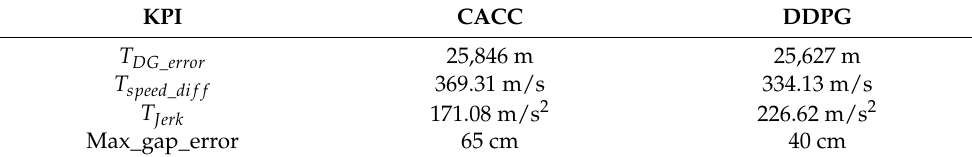
Table 3. Result comparison between CACC and DDPG in case of speed and space gap control.